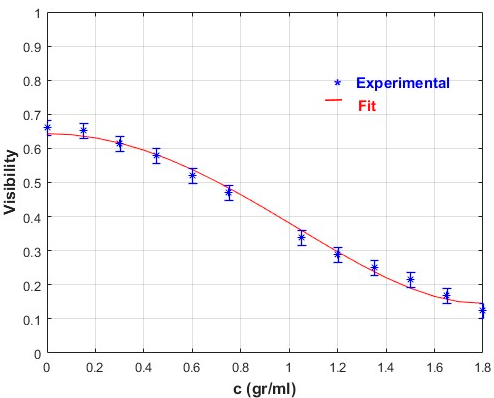
Figure 8. Fourth order polynomial fitted to the experimental points (Fructose).